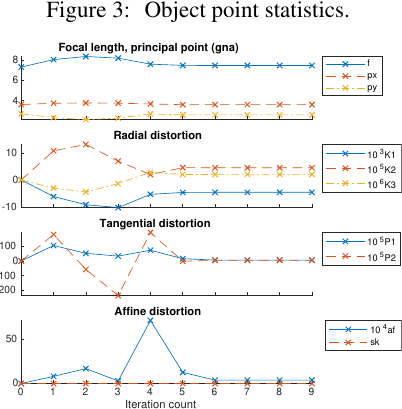
Figure 3: Object point statistics.